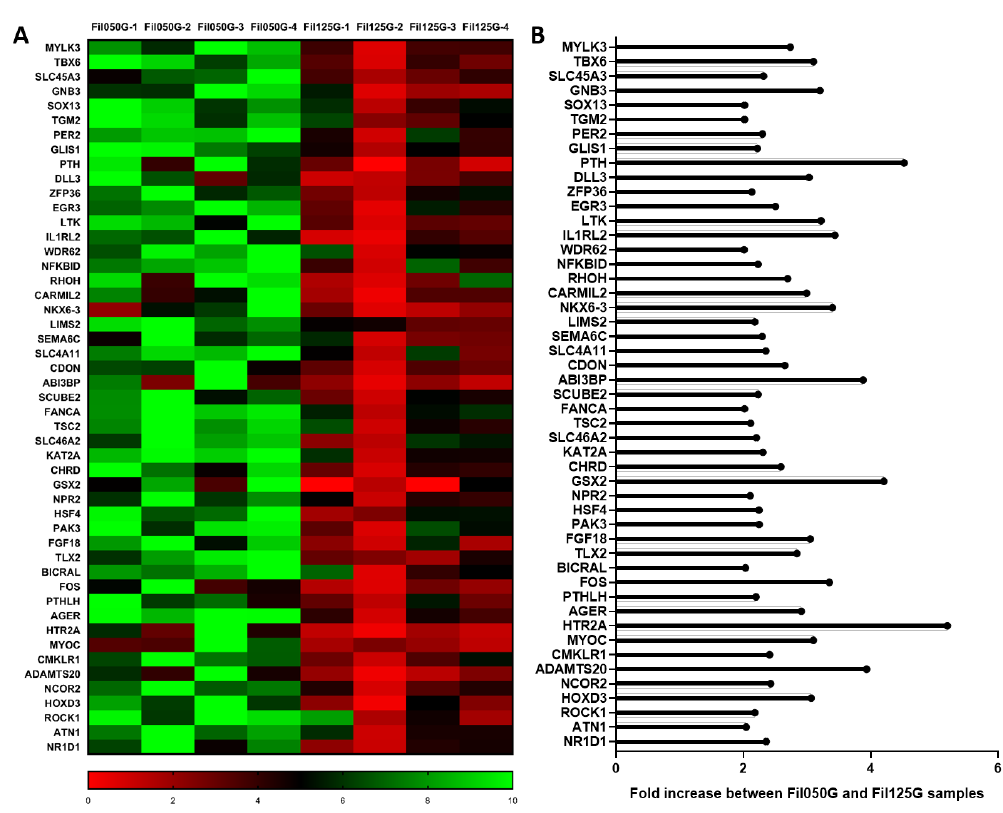
Figure 3. ( A ) Normalized expression of genes linked to regulation of cell differentiation in Fil050G and Fil125G samples ( n = 4; each). ( B ) Fold increase of genes linked to regulation of cell differentiation in Fil050G and Fil125G samples.